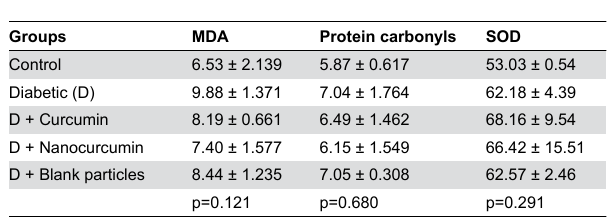
Table 1. The effect of curcumin and nanocurcumin on malondialdehyde (MDA), protein carbonyls and superoxide dismutase (SOD) parameters in rat lens.